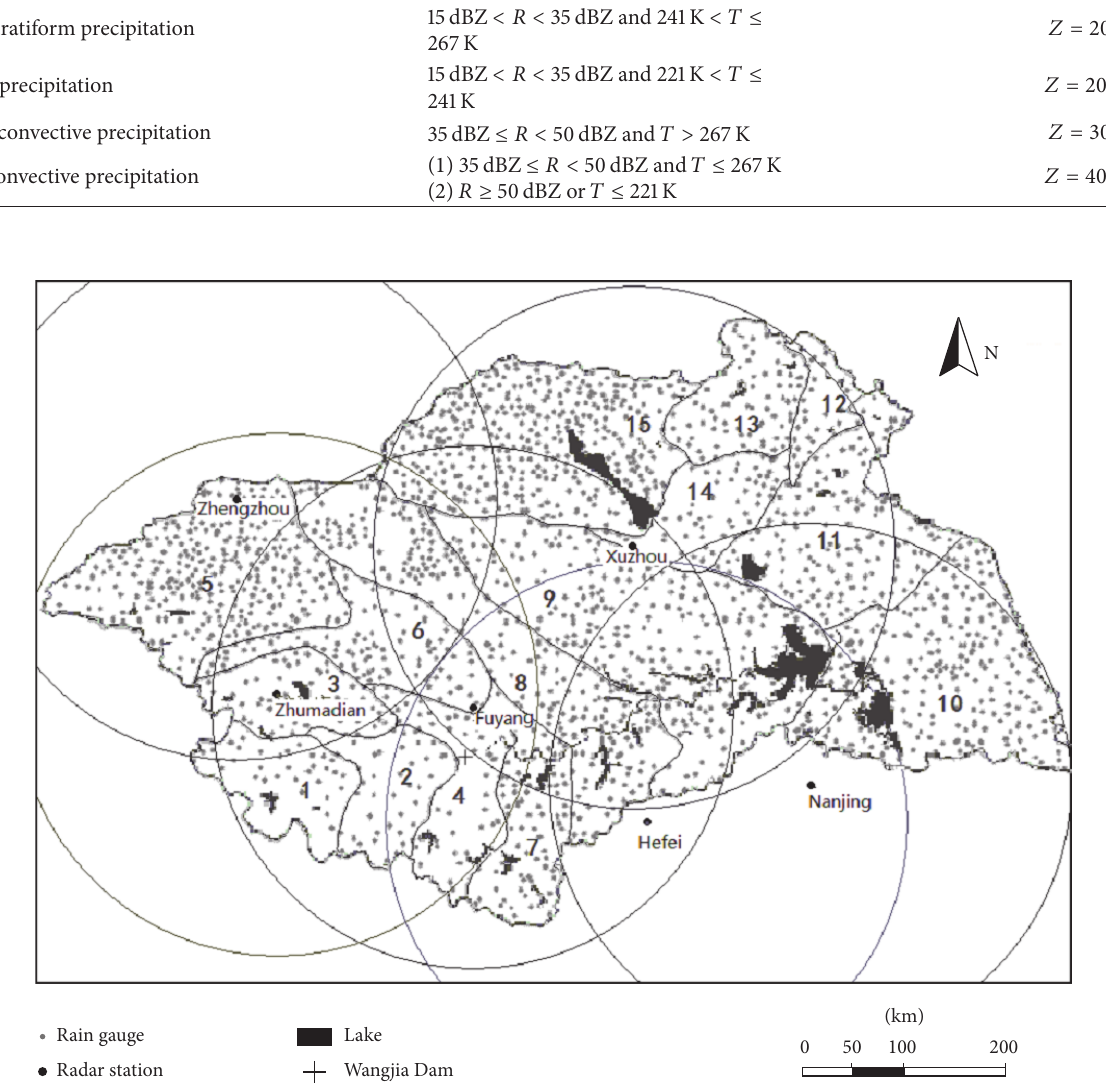
Figure 1: Distribution of the radars and rain gauges in Huaihe River